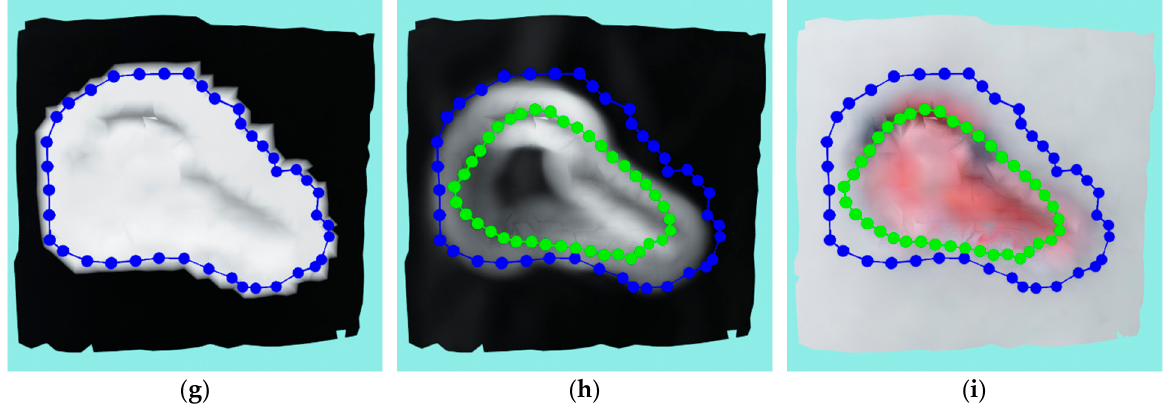
Figure 14. Real example of the ACM application where blue color represent initial contours while green color represent final contours: ( a ) masked mesh and initial contour on the successful run; ( b ) mesh with curvature texture and both initial contour and final contour on the successful run; ( c ) mesh with RGB texture and both initial contour and final contour on the successful run; ( d ) masked mesh and initial contour on the semi-successful run; ( e ) mesh with curvature texture and both initial contour and final contour on the semi-successful run; ( f ) mesh with RGB texture and both initial contour and final contour on the semi-successful run; ( g ) masked mesh and initial contour on the unsuccessful run; ( h ) mesh with curvature texture and both initial contour and final contour on the unsuccessful run; ( i ) mesh with RGB texture and both initial contour and final contour on the unsuccessful run.